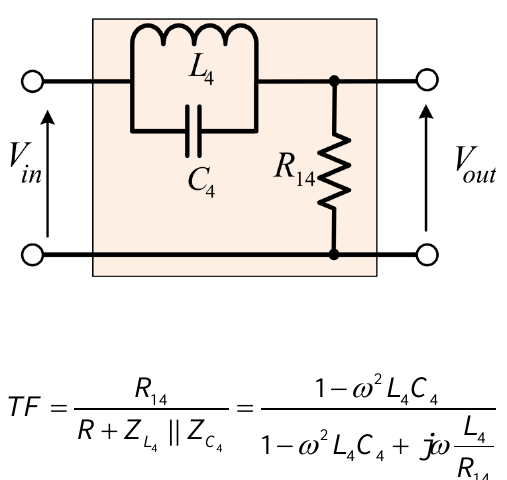
Figure 13. Notch filter diagram.